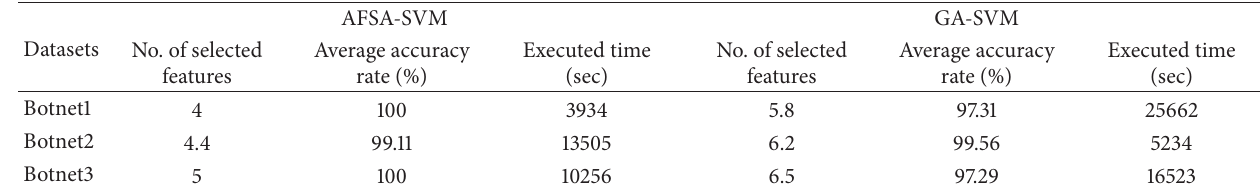
Table 6: The experimental results of AFSA and GA, 10-fold cross-validations.